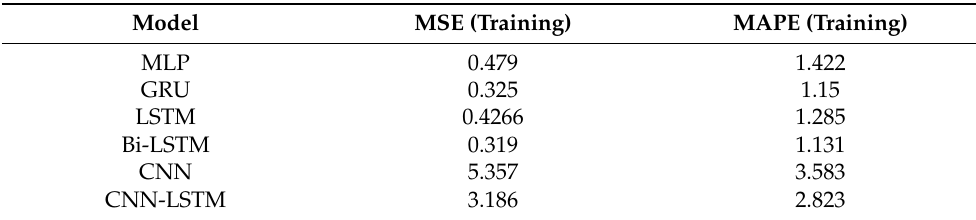
Table 8. The training results of the models using ExxonMobil data with four input features.